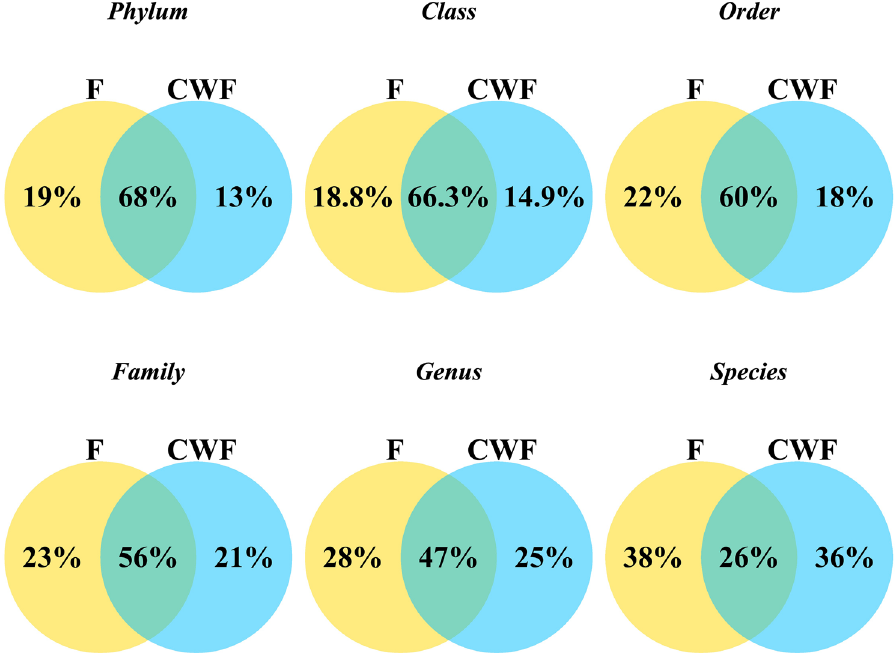
Figure 6. Venn diagrams depicting relative amounts of unique and shared taxa among F and CWF paired samples at phylum, class, order, family, genus and species